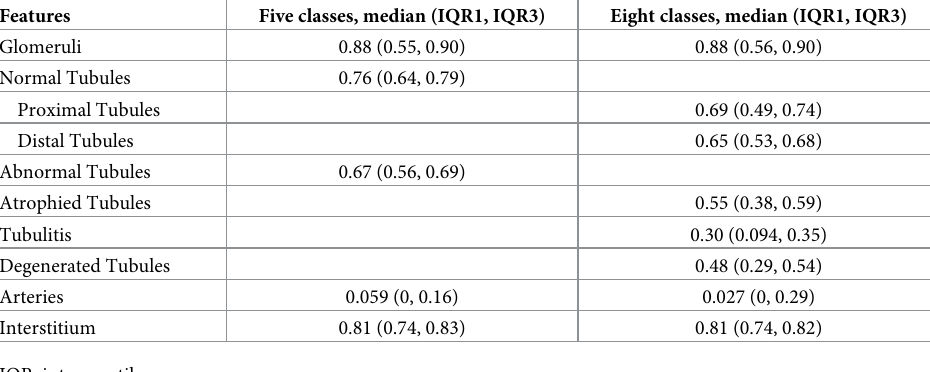
Table 3. Dice coefficients per class.